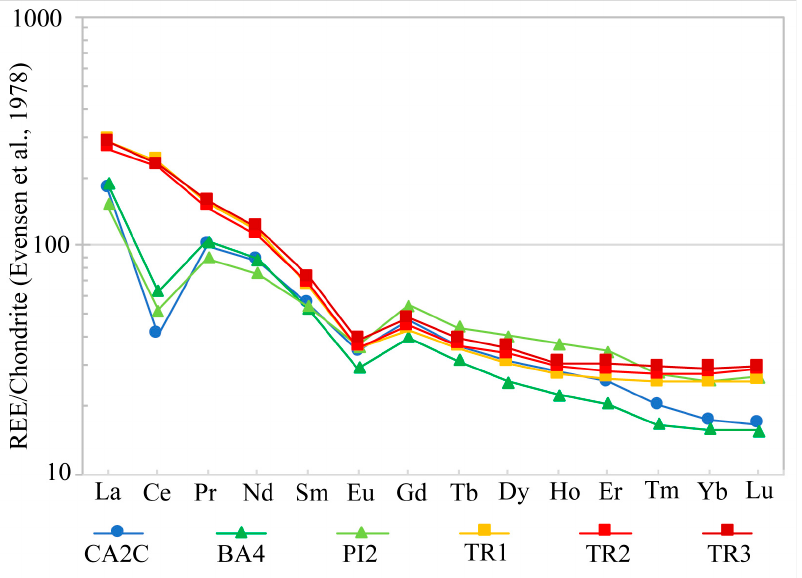
Figure 8. REE pa tt erns normalized to chondrite [40] for selected samples. (CA2C: thickest incrustation; BA4 and PI2: calcite nodules; TR1, TR2, TR2: fi ne-grained portion of terra rossa ). BA4 and PI2: calcite nodules; TR1, TR2, TR2: fine-grained portion of terra rossa